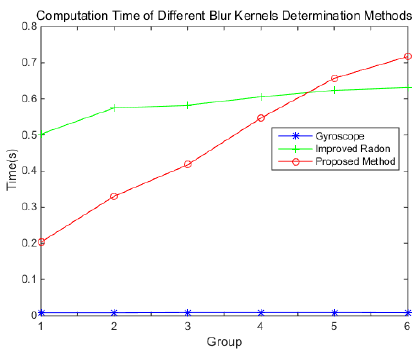
Figure 13. The computation time of different blur kernel determination methods